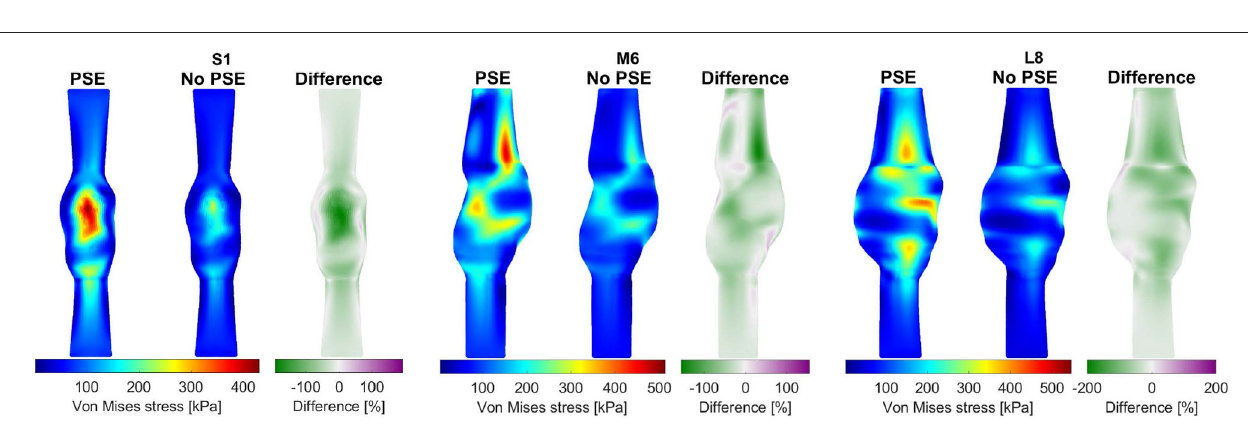
FIGURE 7 | Visualization of the systolic stress resulting from the FSI simulations with and without PSE, and the difference in stress for patients S1, M6, and